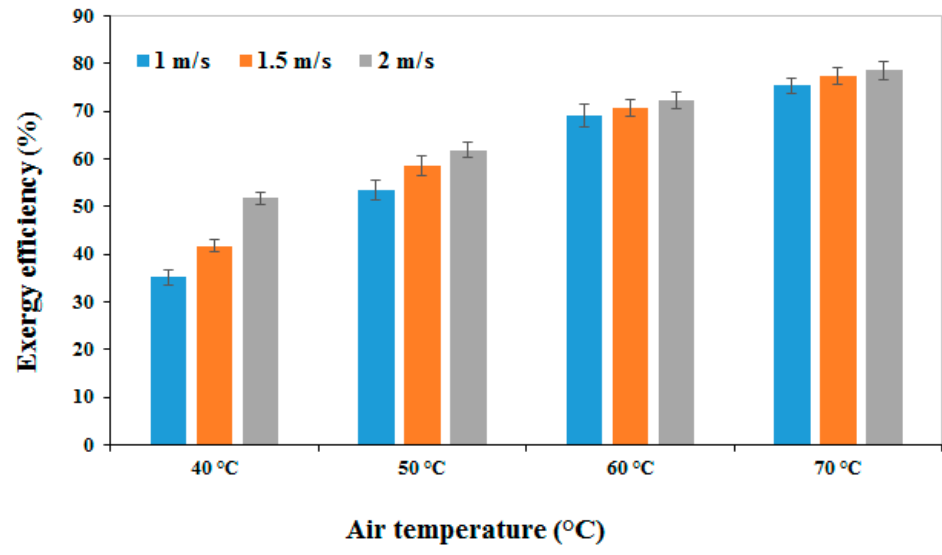
Figure 4. Effect of air velocity and temperature on exergy